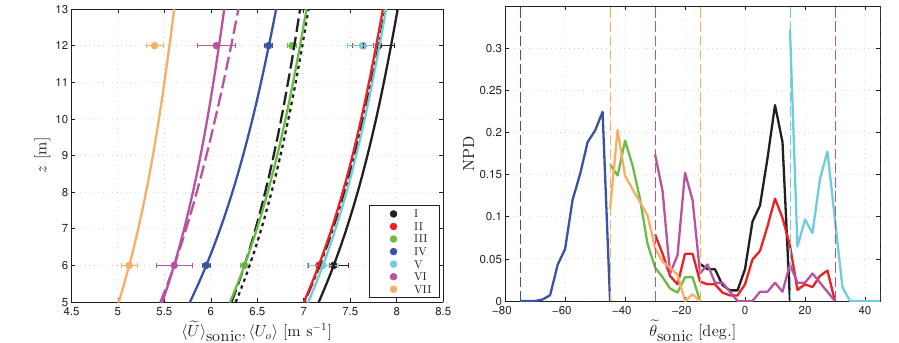
Figure 7. Left panel: inflow conditions for the case studies. The circle markers indicate the ensemble-averaged sonic anemometer measure- Figure 7. (Left) Inflow conditions for the case studies. The circle markers indicate the ensemble-averaged sonic measurements ments (cid:104) e U (cid:105) sonic ( ± the standard error in the error bar) and the lines the estimations of the mean inflow conditions (cid:104) U o ( z ) (cid:105) (see text for details). (cid:2) U (cid:2) (cid:3) sonic ( ± the standard error in the error bar) and the lines the estimations of the mean inflow conditions (cid:2) U o ( z ) (cid:3) (see text for Right panel: normalized distribution (NPD) of the relative wind direction from the 6m sonic anemometer e θ sonic for the case studies. details). (Right) normalized distribution (NPD) of the relative wind direction from the 6-m sonic (cid:2) θ sonic for the case studies 2. estimate a “new” friction velocity u ∗ est with Eq. wind speed at 12 m is equal to the ensemble-average sonic wind speed at the same height. The results in the black dotted line are found with the same methodology as that used for the results in the dashed line but with the 12-m sonic. From these three results, we confirm: first, that turbulent fluxes estimated in the short period of the full-scan are not adequate for deriving the inflow conditions (see the work of Lenschow et al. [20]) and, second, that similar results are obtained when using z o -estimations based on either the 6- or 12-m sonic. This also gives us an idea of the small effect that the internal boundary layer (developed at the coastline) has on the inflow profile at the mast position and within the heights between the sonics.